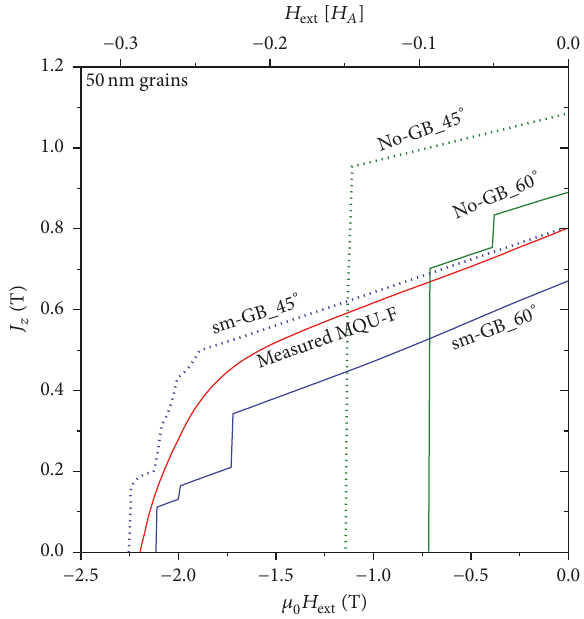
Figure 8: Comparison of the measured demagnetization curve of the MQU-F melt-spun ribbon with calculated curves for directly coupled Nd 2 Fe 14 B grains (no-GB) and grains separated by a weakly soft magnetic GB-phase (sm-GB) with 𝐽 𝑠 = 0.43 T and 𝐴 = 1.0 pJ/T for an average grain misorientation of 45 ∘ and 60 ∘ . The average grain size is 50nm and the average GB thickness is